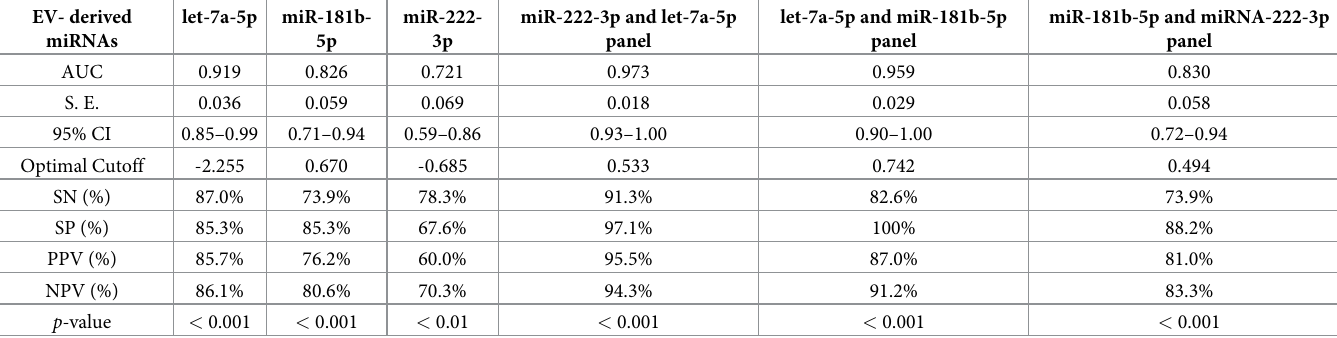
Table 3. ROC curve analysis of individual and combination of sEV-derived miRNAs to differentiate IBC from non-IBC patients. EV- derived let-7a-5p miR-181b- miRNAs 5p